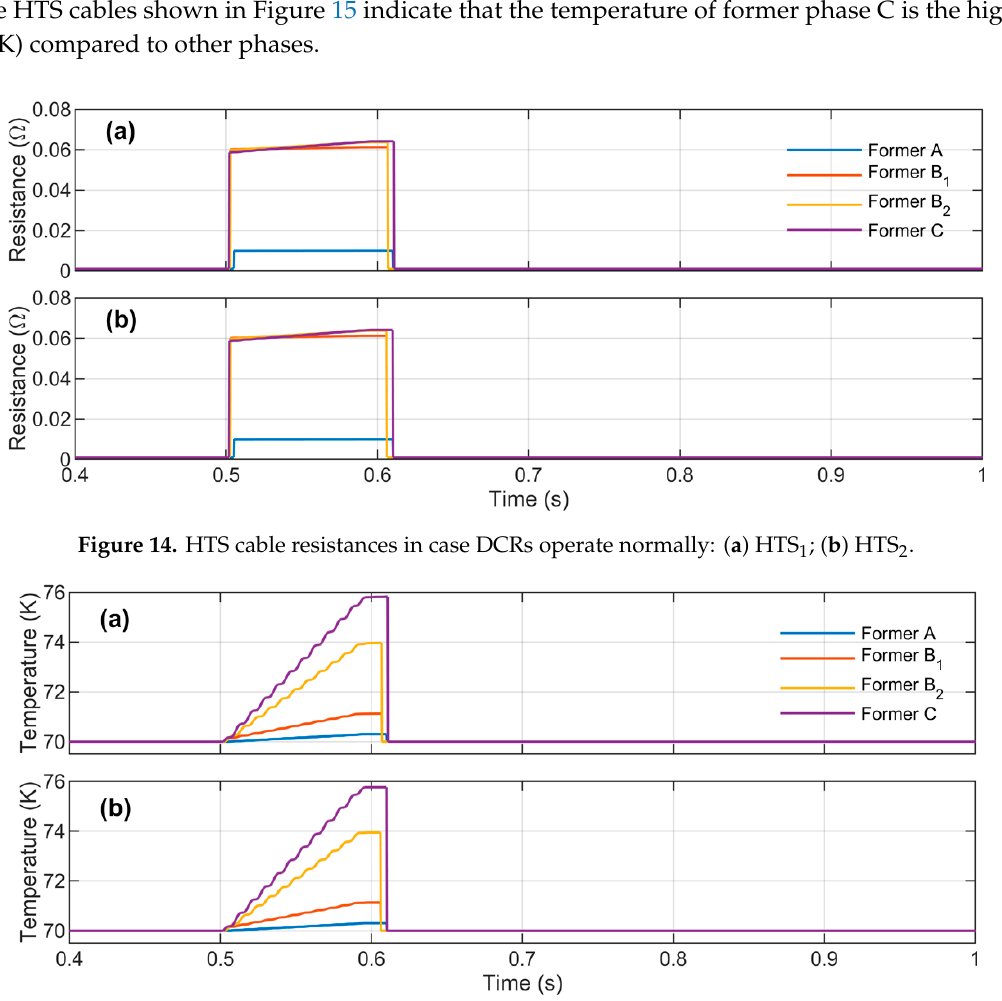
Figure 13. Conducted power in HTS cables in case DCRs operate normally.